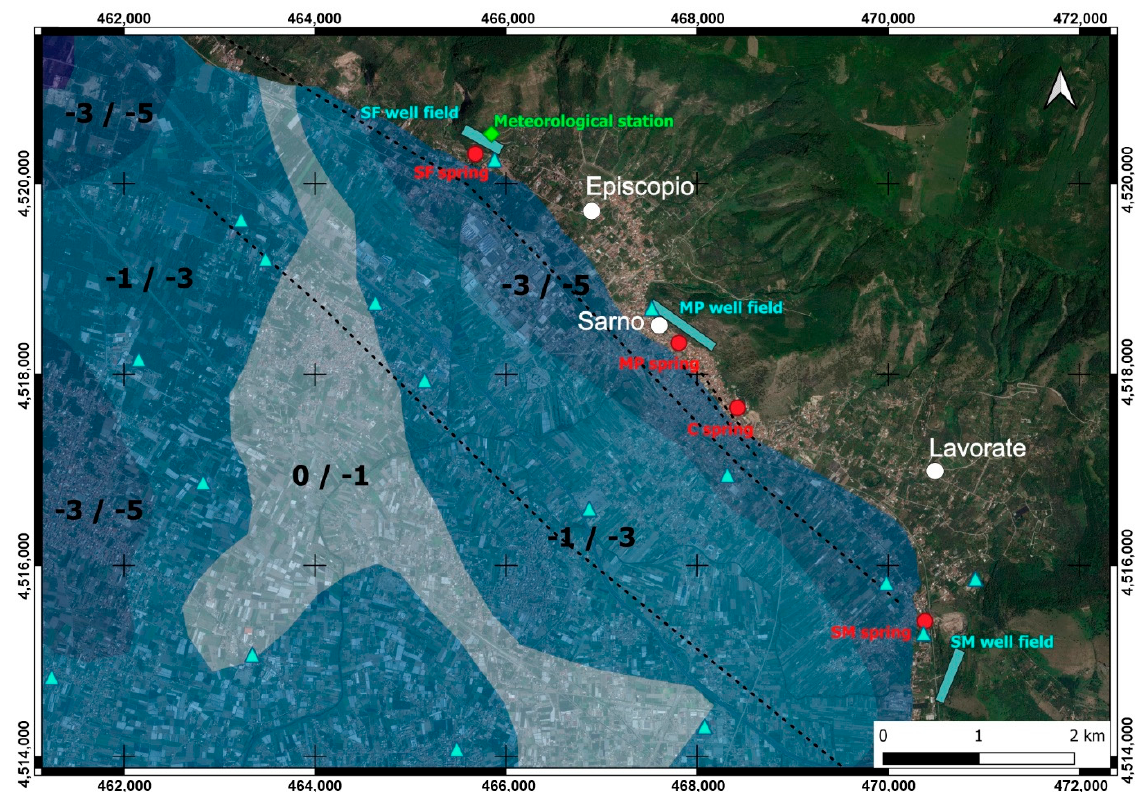
Figure 7 . Piezometric level variation (m) in the period of 1992–2003 for the study area [38, integrated]. Dashed black lines indicate faults mapped in Figure 4.